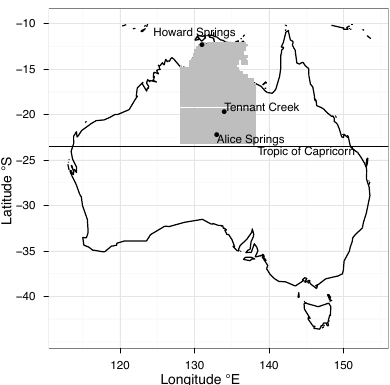
Figure 1: The spatial extent of the NATT study area (gray colour